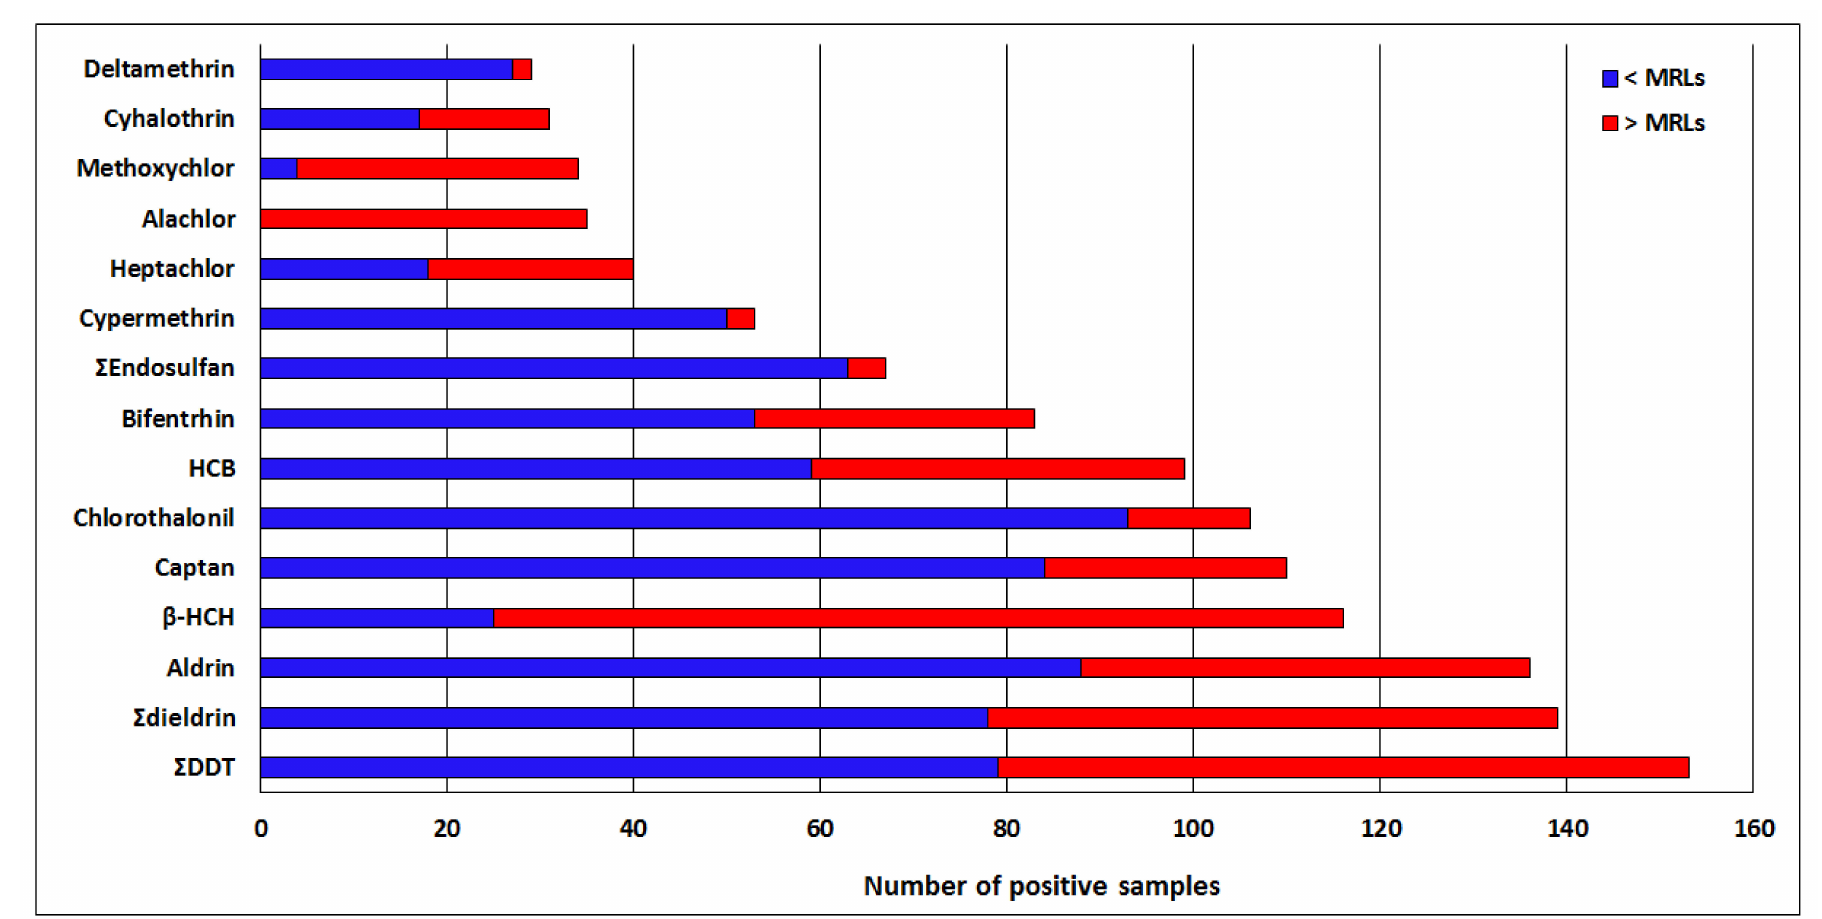
Figure 2. Frequency of positive analyses of regulated halogenated pesticides residues in 11 food items from 3 cities of Cameroon, with indication of number of samples below and above the European Union maximum residue limits (MRLs). HCB = hexachlorobenzene, HCH = hexachlorocyclohexane, DDT = dichlorodiphenyltrichloroethane. Σ DDT = p,p’-DDT + op’-DDT + pp’-DDD + pp’-DDE. Σ dieldrin = aldrin + dieldrin. Σ endosulfan= α -endosulfan + β